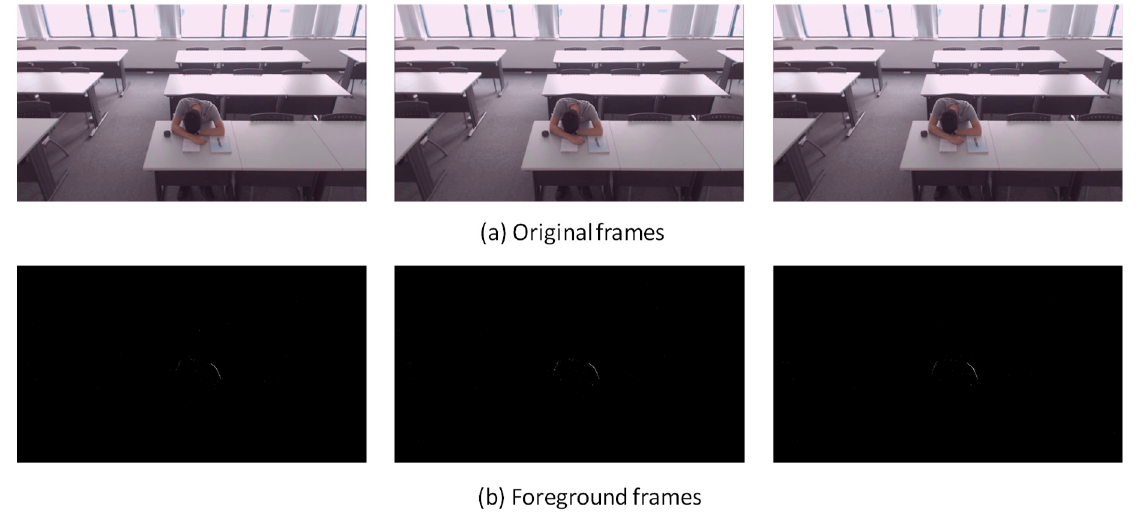
Figure 13. Sleeping—sample images.